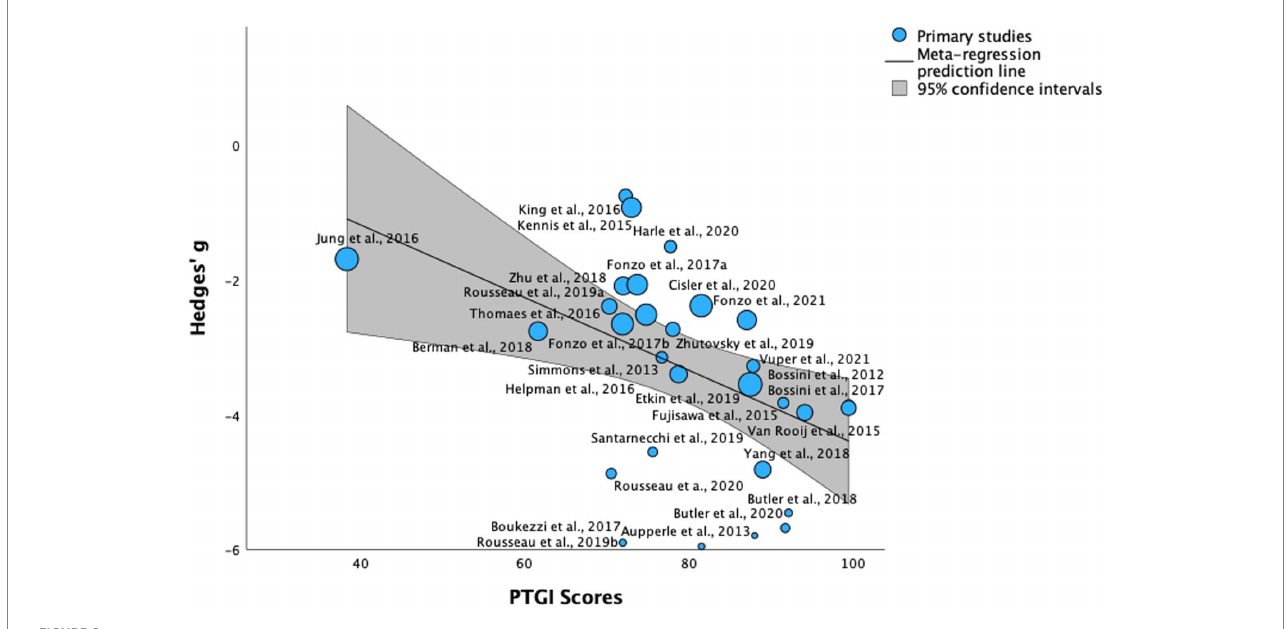
FIGURE 6 Bubble plot of risk of bias across studies. Egger’s test: p =